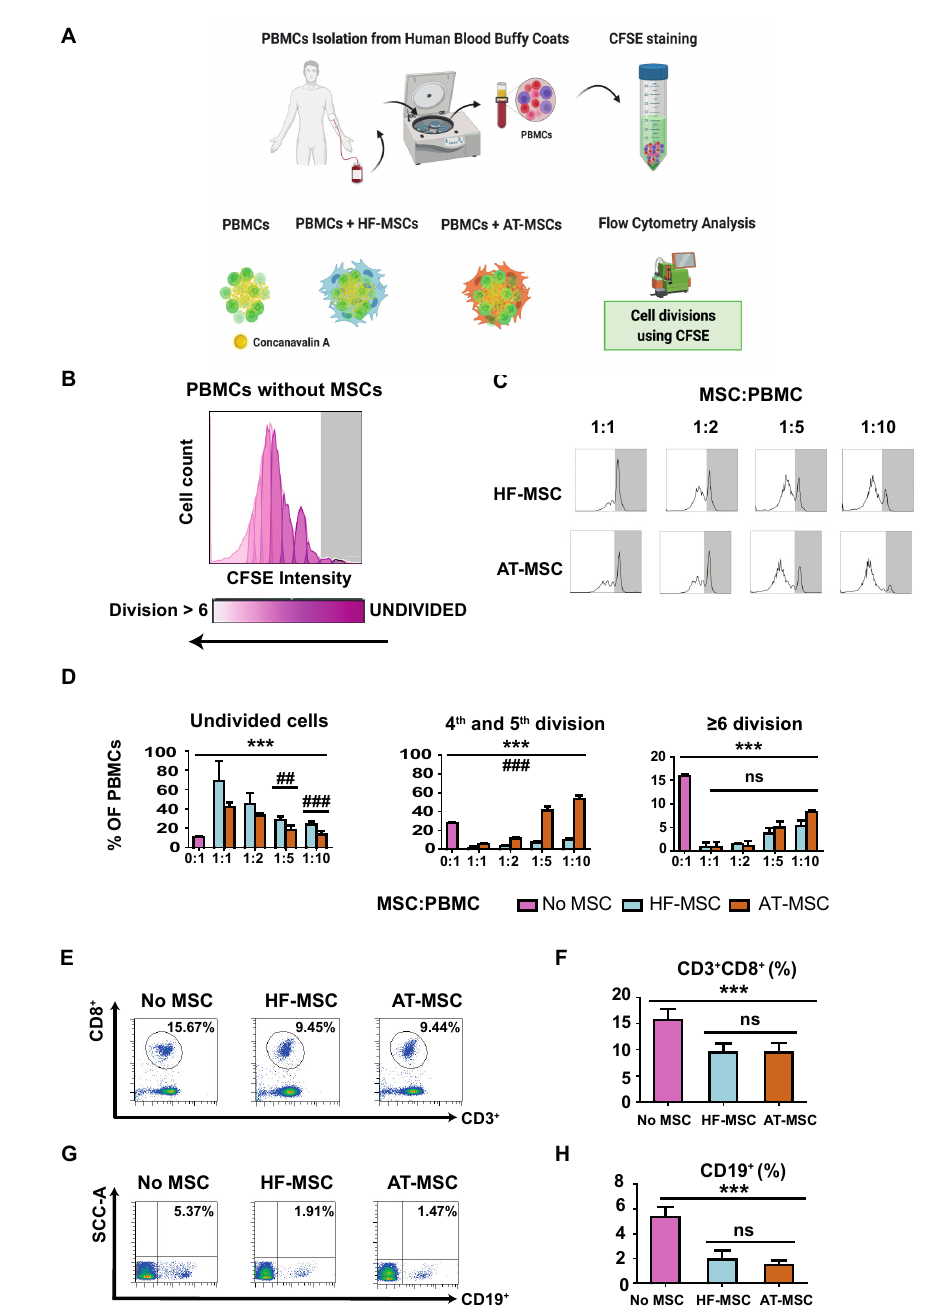
Figure 5. Immunosuppressive effect of MSCs in concanavalin-A stimulated PBMCs. ( A ) PBMCs were isolated from the blood of human healthy donors and stained with CFSE to monitor their proliferation. ( B , C ) Flow cytometry histograms of the proliferation profile of PBMCs alone or co-cultured with MSCs. ( D ) Percentages of PBMCs remaining undivided, undergoing four and five divisions, and undergoing more than or six divisions. ( E , G ) Flow cytometry dot plots depicting the populations of CD3+CD8+ T cells ( E ) and CD19 cells ( G ) and their percentages ( F , H ) when PBMCs were cultured alone or with MSCs. Each datapoint represents the mean for at least three wells ± SD. Statistical significance: *** p < 0.001, ns, no significant difference p > 0.05 when compared with PBMCs without MSCs; ### p < 0.001 and ## p < 0.01 when comparing HF-MSCs with AT-MSCs. ns: not significant differences, p > 0.05. PBMCs, peripheral blood mononuclear cells. HF-MSCs, hair follicle-derived MSCs. AT-MSCs, adipose tissue-derived MSCs.